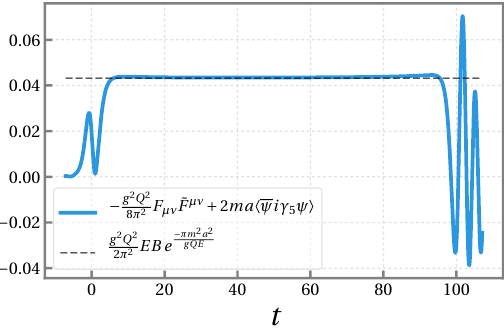
Figure 5 . Contributions to the chiral anomaly equation. The blue solid line shows a numerical evaluation of the chiral charge q 5 , determined by evaluating the right-hand-side of eq. (3.16) [using eqs. (3.15) and (3.8)] as a function of t for the gauge (cid:12)eld given in eq. (3.1). Here we have adopted p p units of g j Q j E = 1, and taken (cid:28) = 100, ma = 1 and g j Q j B = 1. For comparison, the black dashed line indicates ( g 2 Q 2 = 2 (cid:25) 2 ) EBe (cid:0) (cid:25)m 2 a 2 =g j Q j E . If we integrate the blue solid line over time, the integrand is dominated by the plateau, which gives ’ (cid:28) (cid:2) ( g 2 Q 2 = 2 (cid:25) 2 ) EBe (cid:0) (cid:25)m 2 a 2 =g j Q j E , con(cid:12)rming eq.